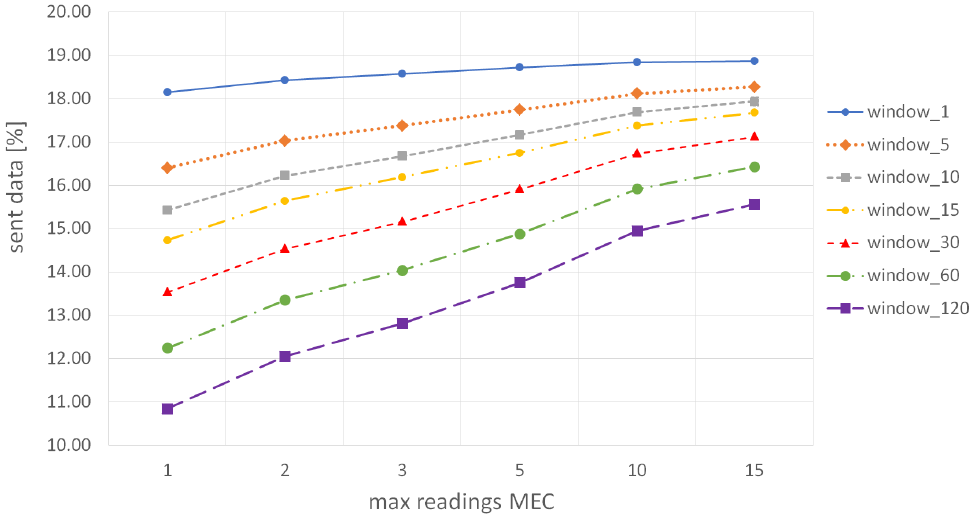
Figure 8. Percentage of data sent by all workers when m worker = 1.